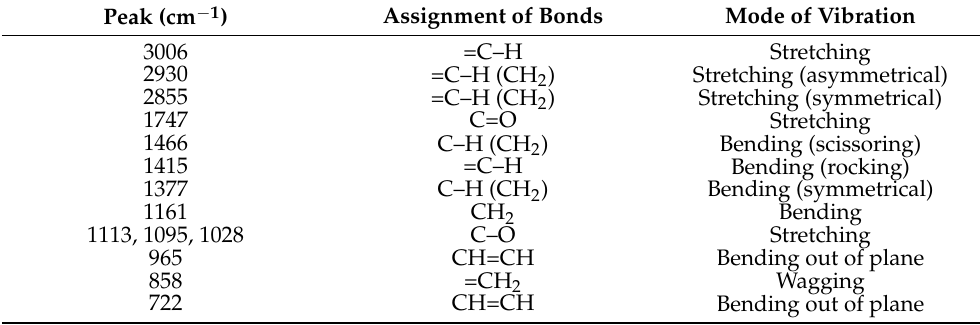
Table 3. Functional groups and mode of vibration from FTIR spectra of the evaluated